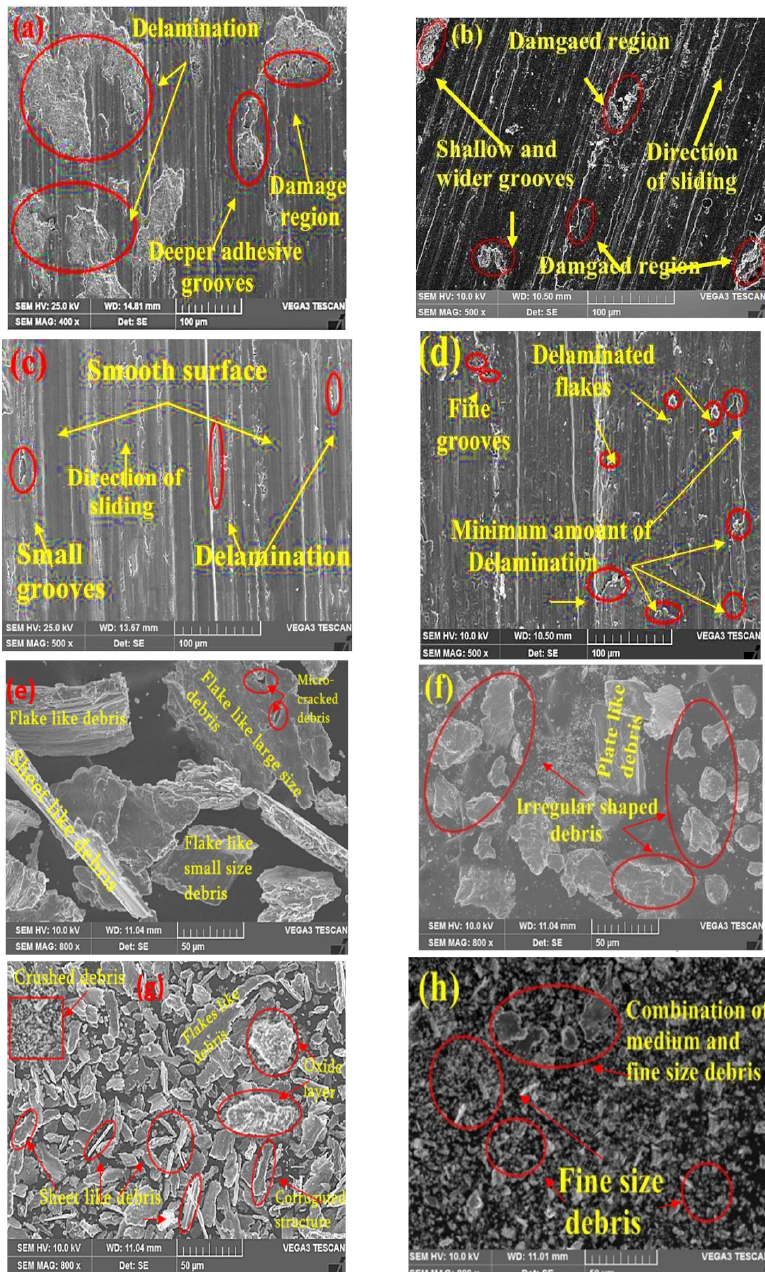
Figure 11. ( a – h ). ( a – d ) Worn surface electron microscopic images of ( a ) un-heat treated Al2014 matrix alloy, ( b ) heat-treated Al2014 matrix alloy, ( c ) un-heat treated Al2014-15 wt.% Al 2 O 3 and ( d ) heat-treated Al2014-15 wt.% Al 2 O 3 composites, respectively, with a load of 49.05 N, sliding speed of 400 rpm, and sliding distance of 2000 m. ( e – h ) Debris analysis of electron microscopic images of ( e ) Al2014 matrix alloy without heat treatment, ( f ) Al2014-15 wt.% Al 2 O 3 composite with heat-treatment, ( g ) Al2014-15 wt.% Al 2 O 3 composite without heat treatment and ( h ) Al2014-15 wt.% Al 2 O 3 composites, respectively, at a load of 49.05 N, sliding speed of 400 rpm, and 2000 m. Figure 11e indicates that the size of the sheet- and flake-like debris becomes much larger; indicating that the matrix becomes smooth with the above-mentioned wear testing conditions and results in the change from moderate to extreme wear. The micro-cracks were formed because of the occurrence of repeated stress while sliding at a greater load [61]. This means that the matrix is softer with a greater load of 49.05 N, sliding speed of 400